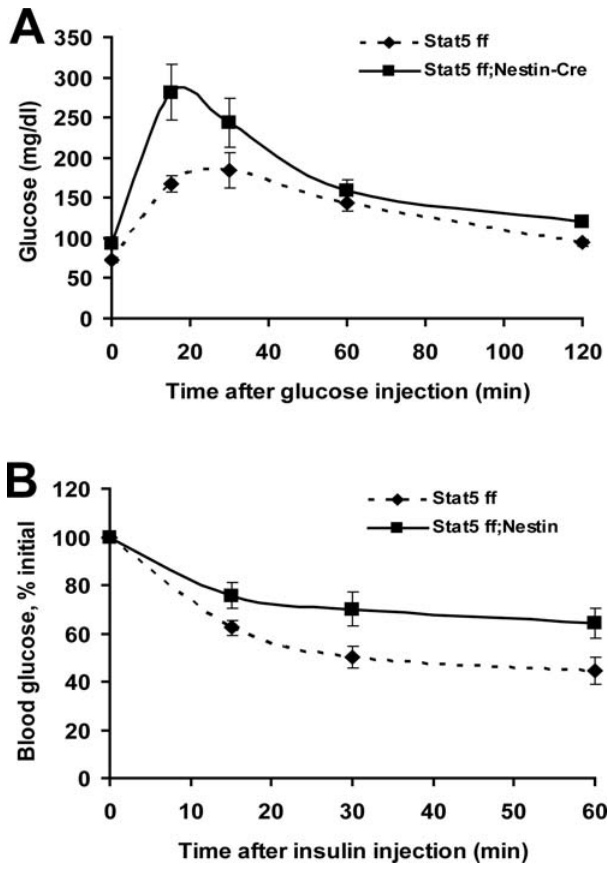
Figure 5. Glucose and insulin tolerance tests in 22 week-old Stat5 fl/fl and Stat5 fl/fl;Nestin-Cre mice. (A) Glucose tolerance tests were performed on fasted 22 week-old female mice after an i.p. injection of 2 g/kg BW glucose. Results are expressed as average blood glucose level 6 SEM of 5 females of each group. The effect of genotype was significant (Two Way Repeated Measured ANOVA with Holm-Sidak test: (F(1,24)=6.6, p=0.033. (B) Insulin tolerance test on 22 week-old females. Mice were fasted for 9 hours followed by the administration